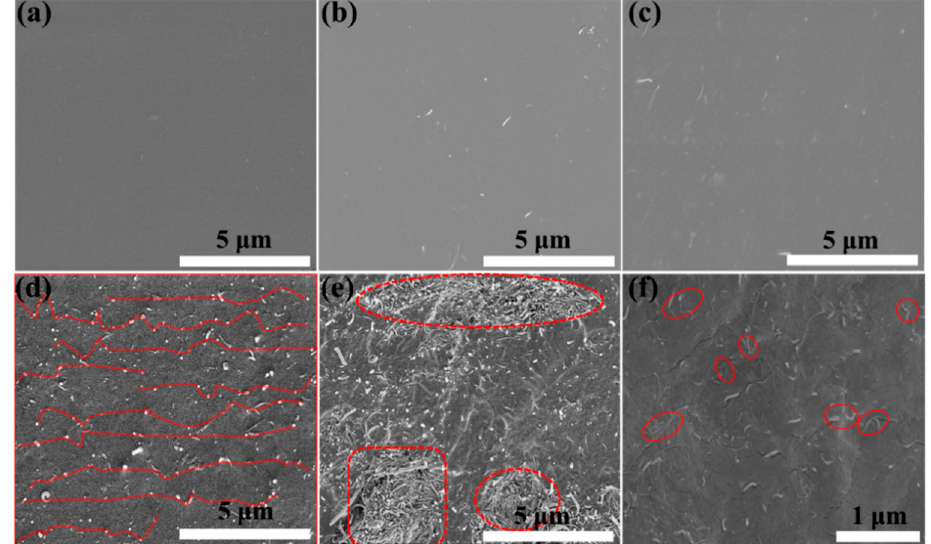
Figure 6. SEM cross-sectional micrograph of ( a ) pure PVA film; ( b – e ) PVA/CS@MWCNTs composite film with a loading of 1 wt%, 3 wt%, 5 wt%, and 7 wt% MWCNTs; SEM surface micrograph of PVA/CS@MWCNTs composite film with a 5 wt% MWCNTs loading.